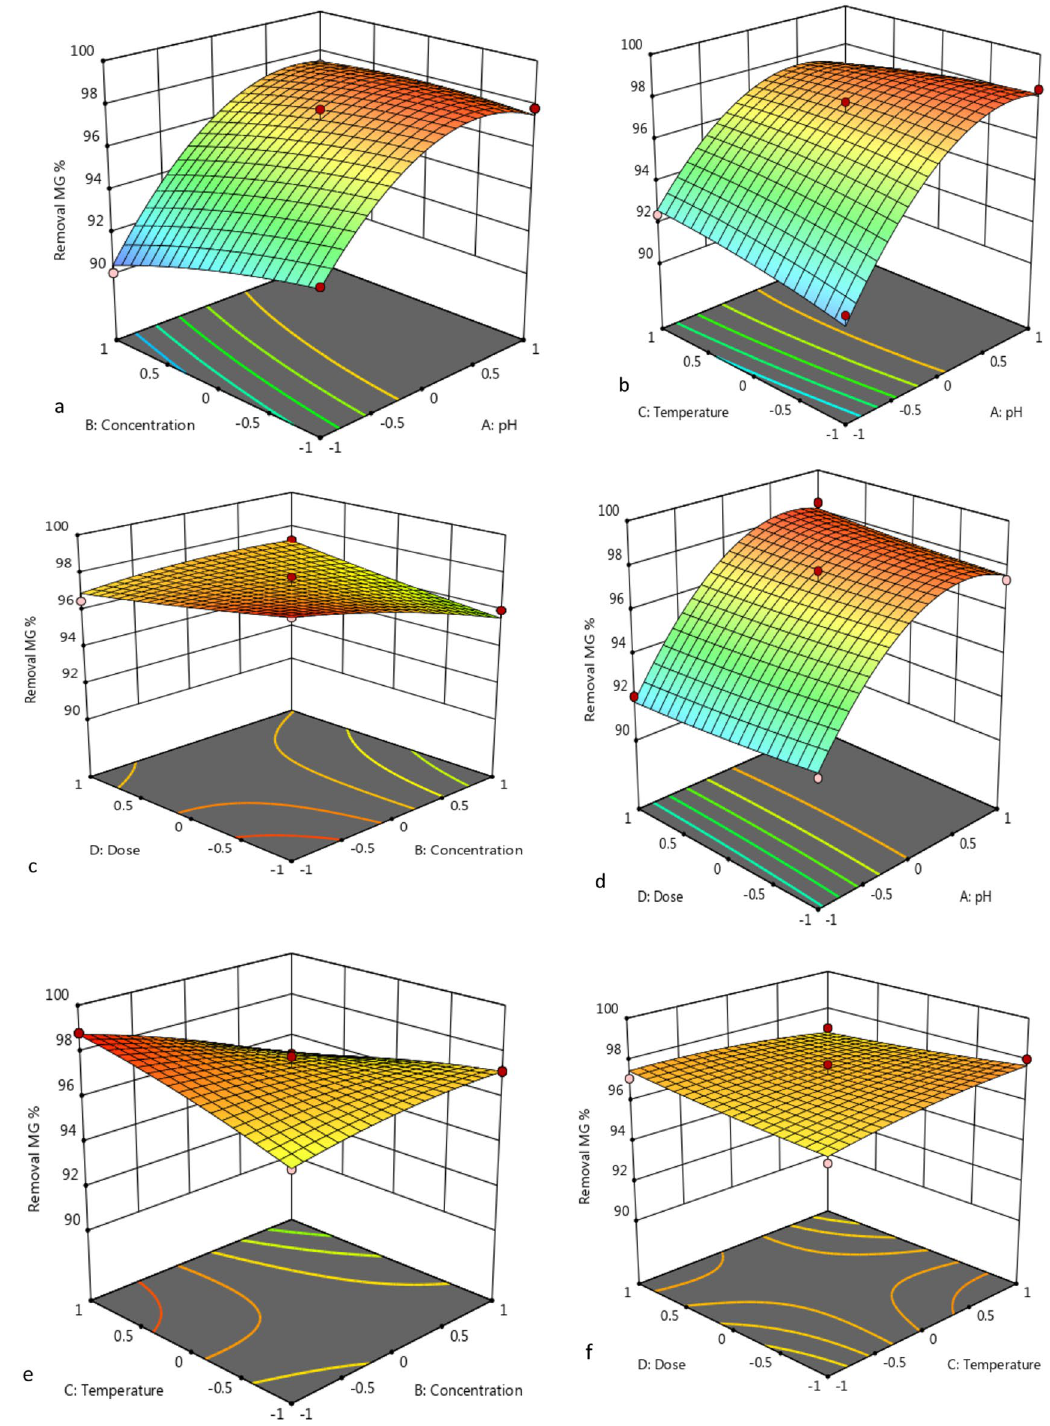
Figure 12. 3D response surface plot of MG removal % through nano bentonite as a function of pH, temperature and adsorbent